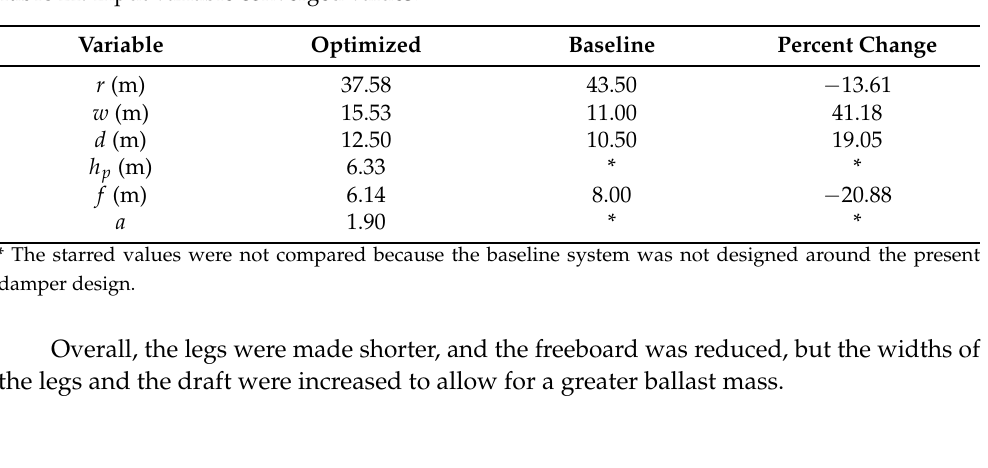
Table 21. Input variable converged